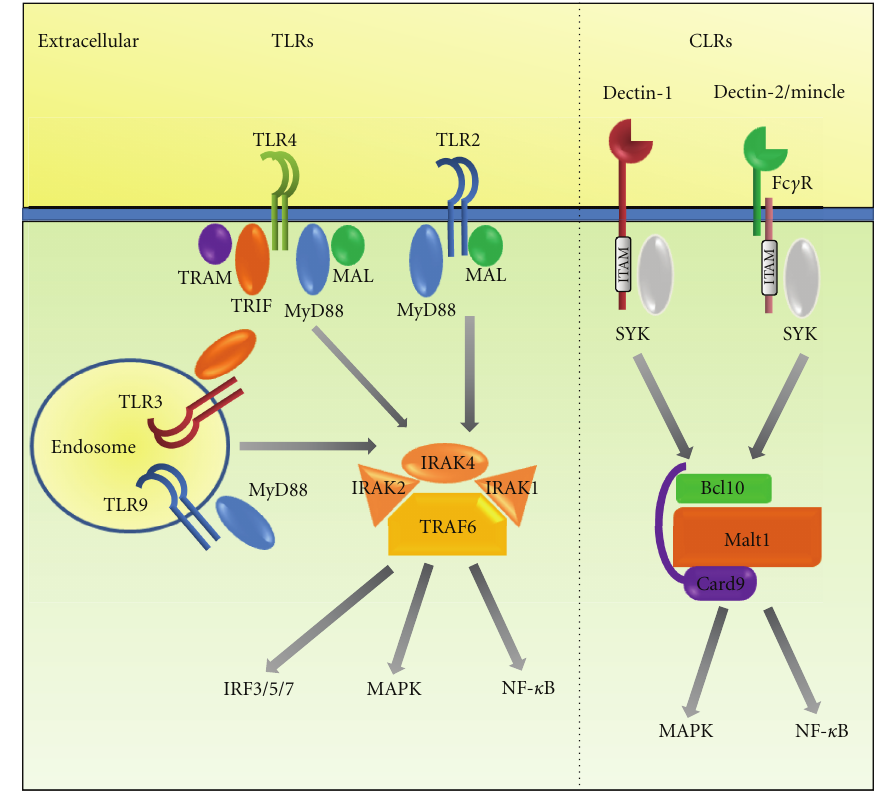
Figure 1: Signal pathway activation by the main TLR and CLR receptors that detect Candida . Signalling through TLRs proceeds mainly via TRAF6 with a variety of adaptor proteins acting as intermediaries between receptor and TRAF6. Foremost among these is MyD88 which is utilised by all known TLRs except TLR3. As well as MyD88, there are other adaptor molecules, including TRIF, MAL, and TRAM, with the di ff erent TLRs using di ff erent combinations of these adaptors. Activation of these adaptors leads to activation of IRAK1, 2, and 4 followed by ubiquitination of TRAF6 which leads to subsequent activation of downstream signalling pathways. Signalling through CLRs utilises cytoplasmic ITAM domains to interact with the SYK adaptor molecule, activating the Card-9-Bcl10-Malt1 protein complex. Some CLRs, such as Dectin-1, include a modified ITAM domain in their cytoplasmic domain. Others, such as Dectin-2, associate with other receptor molecules, notably the FcR γ and DAP12 proteins, which possess the ITAM domain that transduces the signal into the cell. In all cases, the net e ff ect is to activate the MAPK and NF- κ B pathways, leading to upregulation of specific gene transcription. In addition to this, TLRs are also known to activate transcription via members of the IRF family, including IRF3, IRF5, and